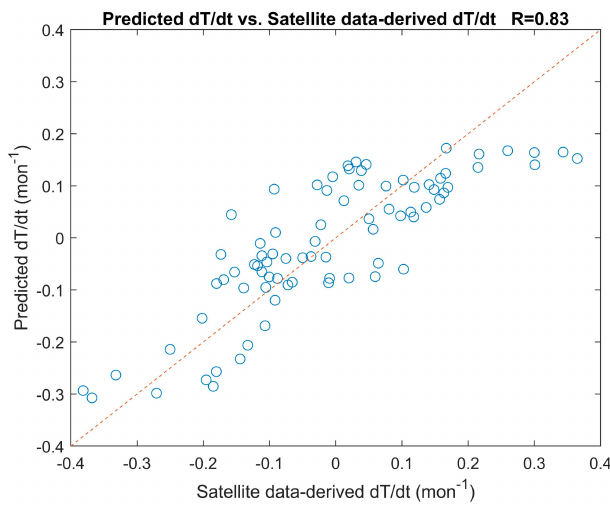
Figure 3. The predicted dT / dt derived from Equation (7) versus satellite-data-derived dT / dt .